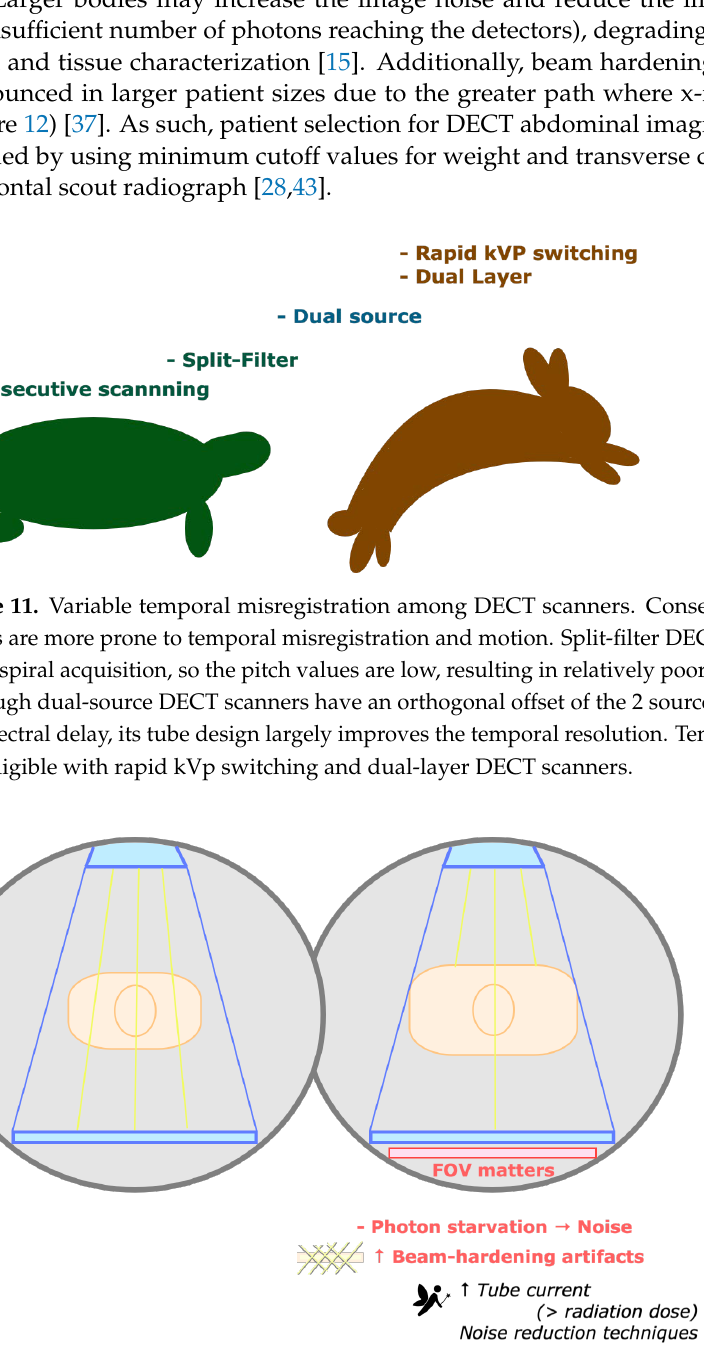
Figure 12. Impact of patient size in DECT image quality. Larger bodies may increase the image noise and reduce the image quality (given the insufficient number of photons reaching the detectors, represented by yellow lines). Beam hardening artifacts are more pronounced in larger patient sizes. Potential strategies to improve image quality include increasing the tube current and using noise reduction techniques. Noise is also reduced with the novel photon-counting scanners. The limited field of view (FOV) for dual-energy imaging in dual-source scanners may be a problem in larger patients.